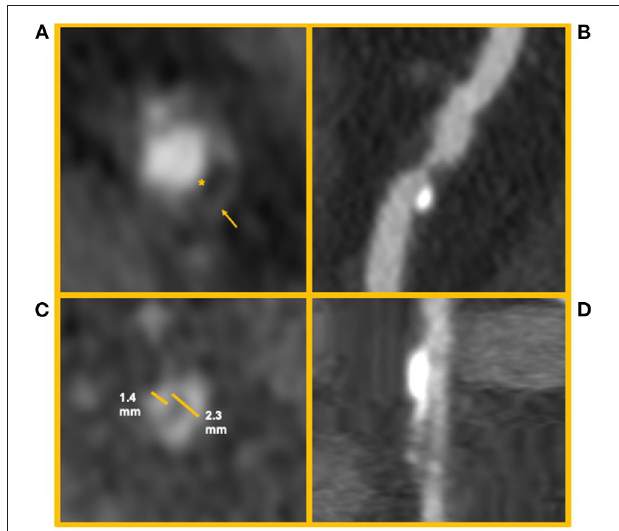
FIGURE 5 | High risk features of coronary artery plaques. The figure shows clinical examples of high-risk plaque feature. (A) Depicts an example of a Napkin-ring sign. The asterisk identifies the hypodense necrotic core; the arrow identifies the hyperdense ring-like thin cap. (B) Depicts a high-risk coronary plaque with spotty calcifications and low attenuation (i.e., attenuation < 30 HU). (C,D) Depict a coronary artery plaque with positive remodeling (i.e., a positive ratio between diameter of the vessel outside the plaque and its internal diameter) in short and long axis,